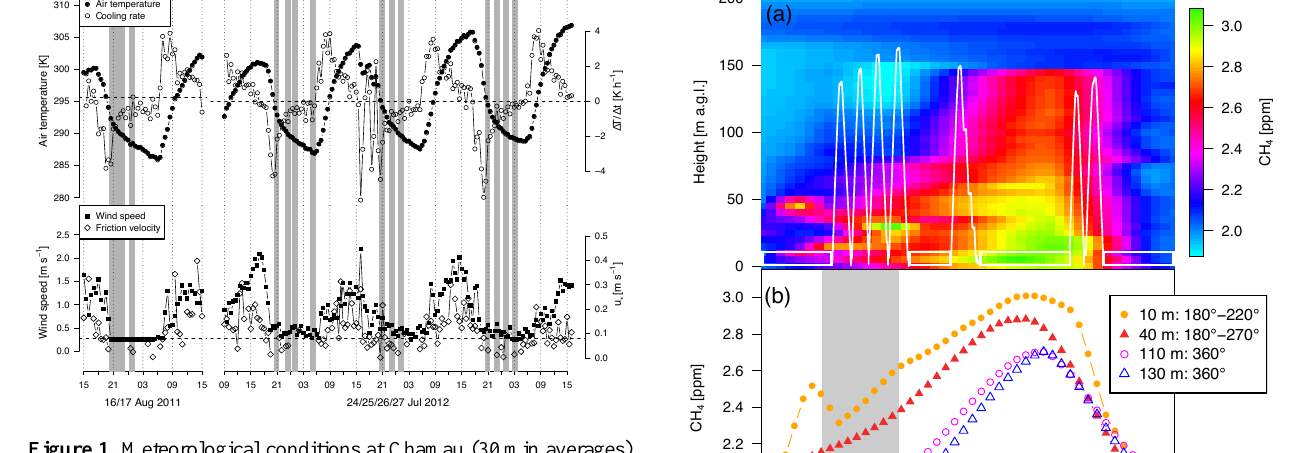
Figure 1. Meteorological conditions at Chamau (30min averages) during the balloon measurements (grey shaded areas) in 2011 and 2012. Top panel: air temperature and cooling rates (cid:49) ¯ T/(cid:49)t at 2ma . g . l . ; bottom panel: wind speed and friction velocity u ∗ at 2ma . g . l . Dashed horizontal lines show the cooling rate threshold